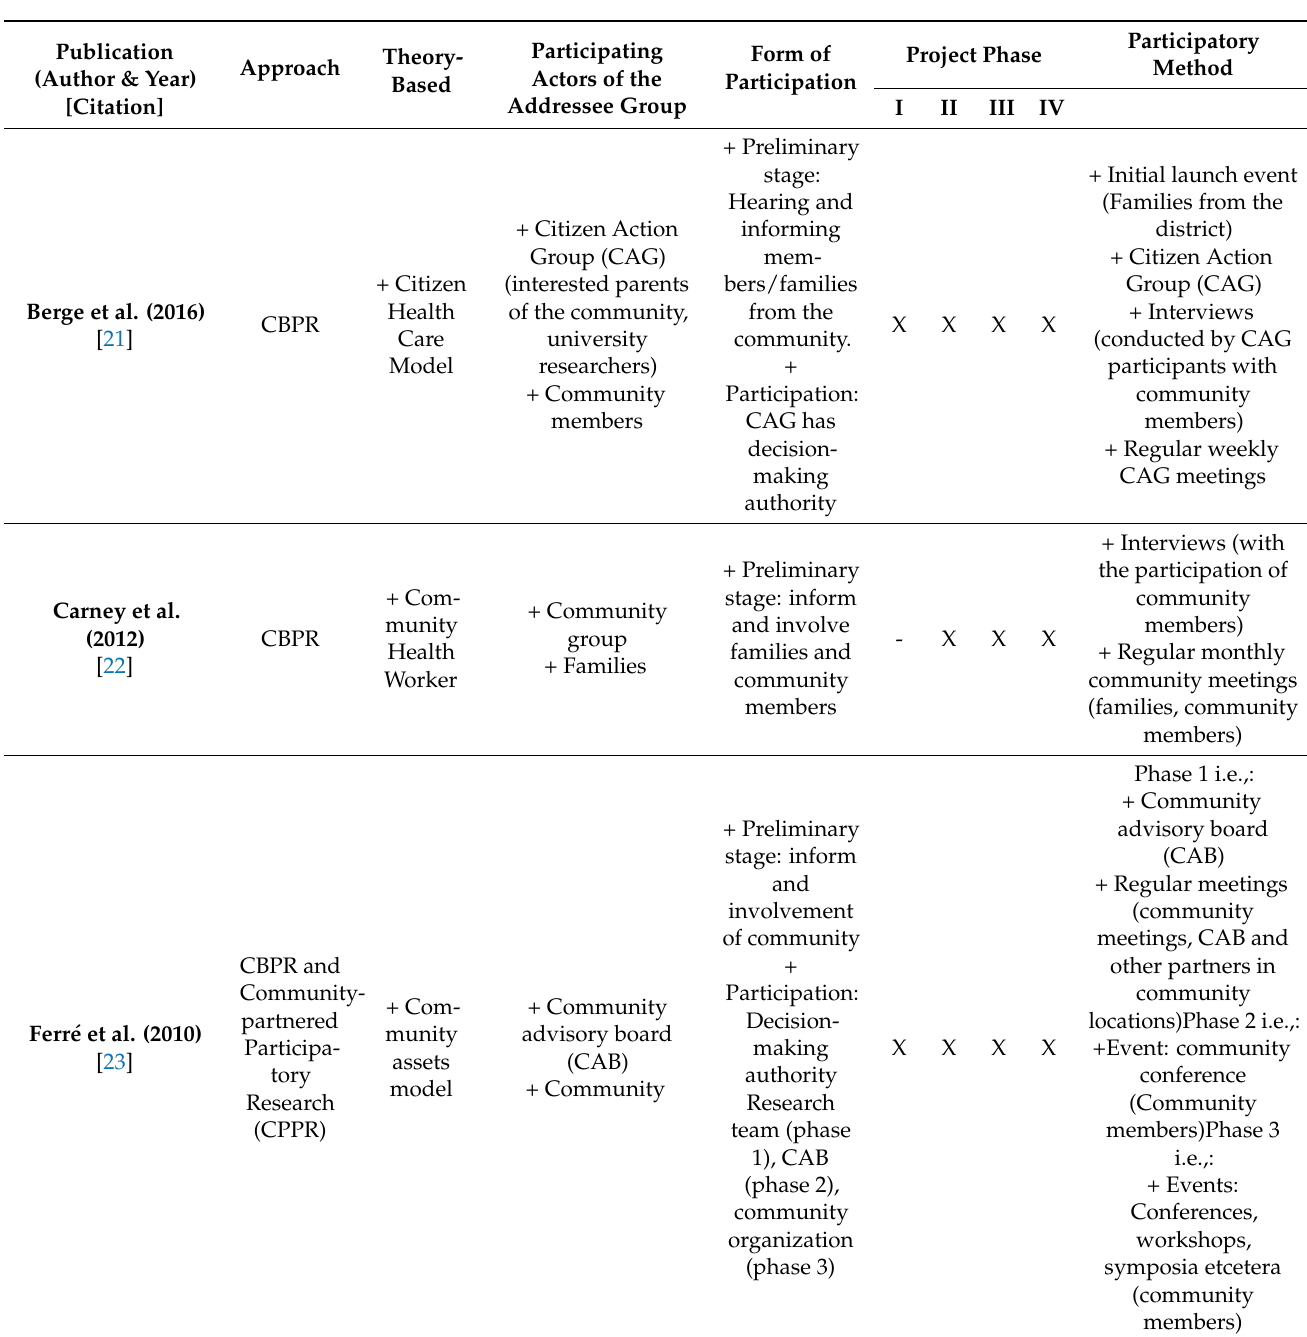
Table 2. Approaches and methods of participatory family health promotion and prevention in the publications